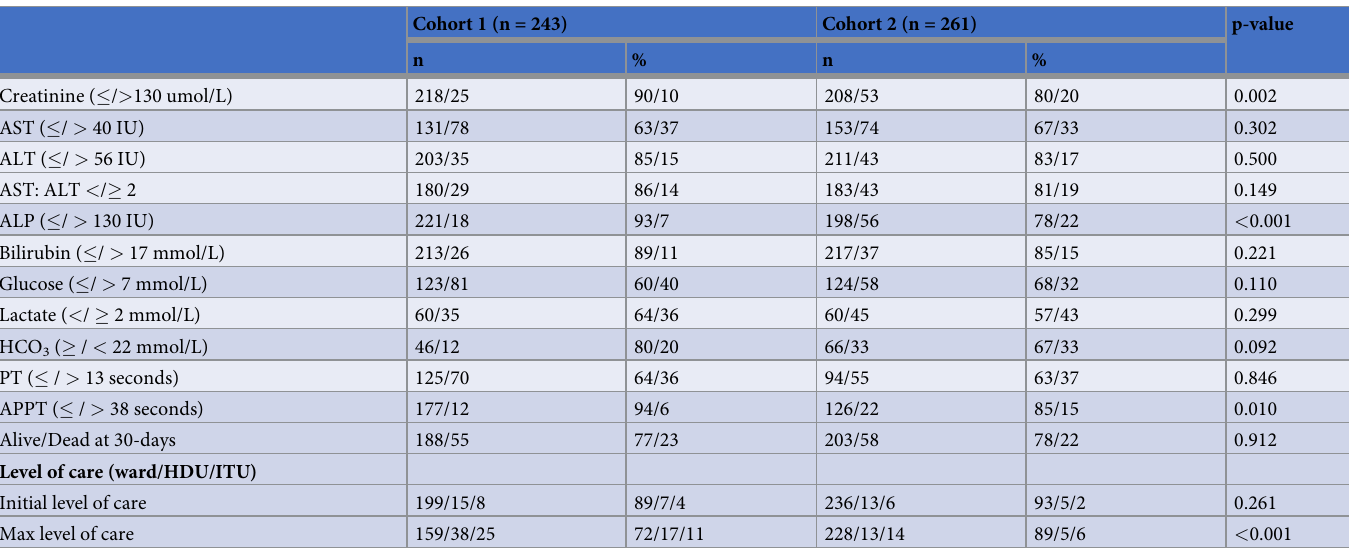
poGPS: Peri-operative Glasgow Prognostic Score; NLR: neutrophil lymphocyte